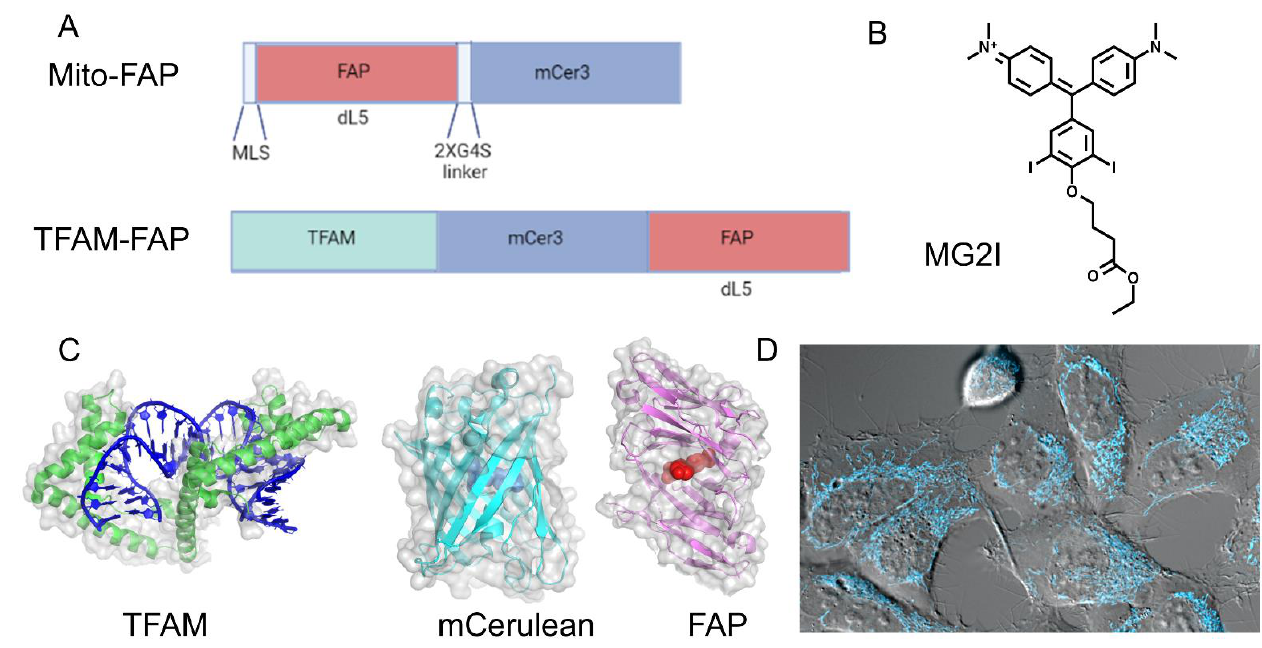
Figure 2. Mitochondrial-targeting chemoptogenetics constructs. We have created a highly con- trolled system that can help to elucidate the downstream effects of ROS damage within mitochondria. ( A ) The structure of the Mito-FAP and TFAM-FAP constructs. ( B ) The structure of the MG2I dye, that when bound by FAP and exposed to near-infrared wavelengths (642–660 nm), generates singlet oxygen. ( C ) The structure of several molecules in our chemoptogenetics system. TFAM is closely associated with mtDNA and upon fusion to the mCerulean-FAP construct, targets the ensuing sin- glet oxygen to mtDNA. mCerulean is a constitutively active fluorescent protein that allows one to visualize the subcellular location of the construct. The fluorogen-activating protein (FAP) is bound to the MG2I dye, which in the presence of near-infrared light, generates ROS as described above. ( D ) HEK293 cells stably transfected with TFAM-FAP, visualized within mitochondria via mCerulean